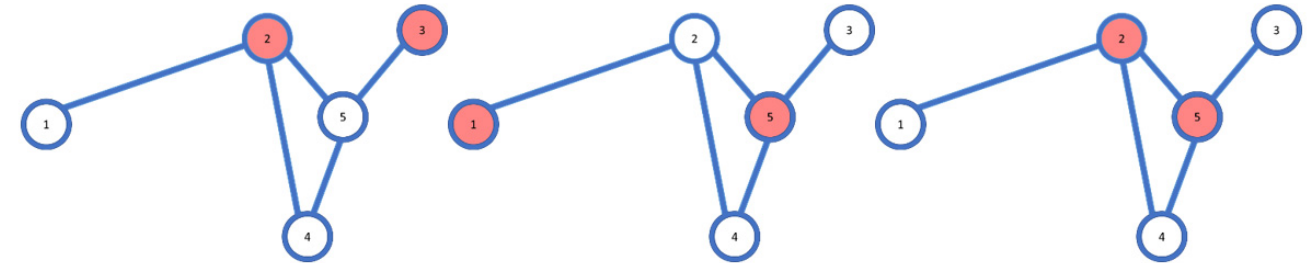
Figure 1. A five node network with three possible Dominating Sets.